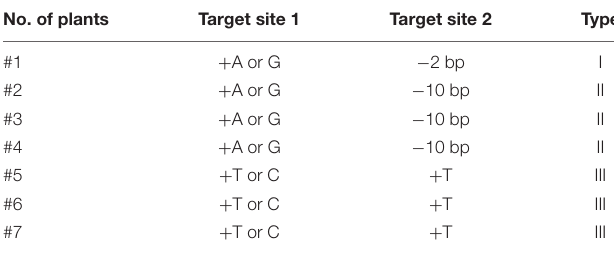
TABLE 2 | Gene-editing types for two target sites of ORF18 in T 0